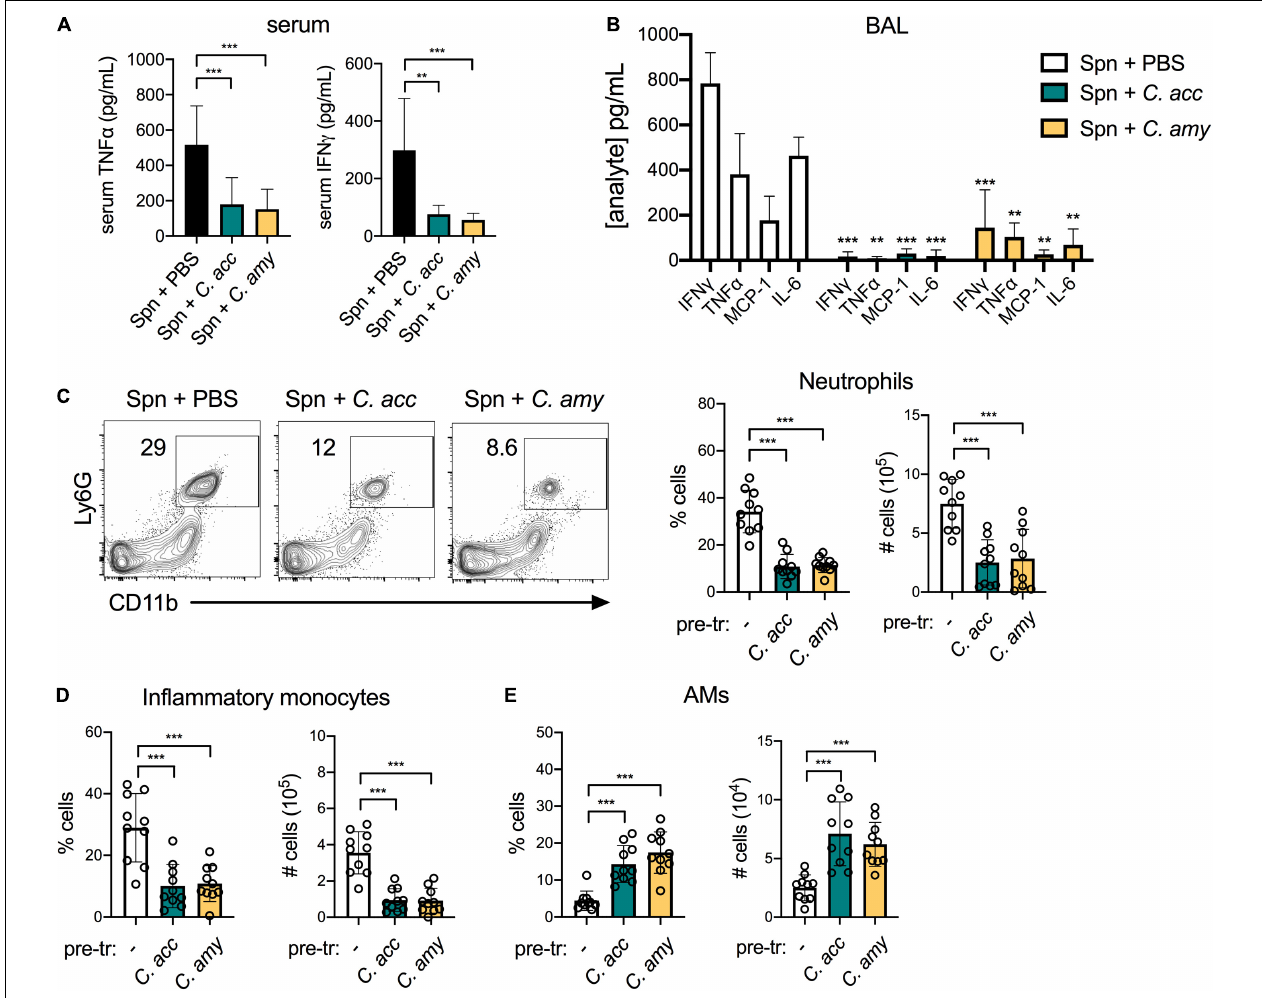
FIGURE 5 | Reduced inflammation and inflammatory myeloid cell recruitment in the lungs of Corynebacterium-S. pneumoniae co-infected mice. Systemic TNF α and IFN γ detected in mice pre-exposed to PBS (–), C. acc or C. amy at 24 h post- S. pneumoniae (Spn) infection (A) . Cytokines and chemokines detected in lung BAL in mice pre-exposed to PBS (–), C. acc or C. amy at 24 h post-Spn infection (B) , significance indicated relative to mice pre-exposed to PBS (none). Percentage and total number of neutrophils (C) , inflammatory monocytes (D) , and alveolar macrophages (AMs) (E) detected by flow cytometry in the lungs of mice pre-exposed to PBS (–), C. acc or C. amy at 24 h post-Spn infection. Data are pooled from three independent experiments with 3–5 mice per group. ** p < 0.01, *** p < 0.001, ANOVA.